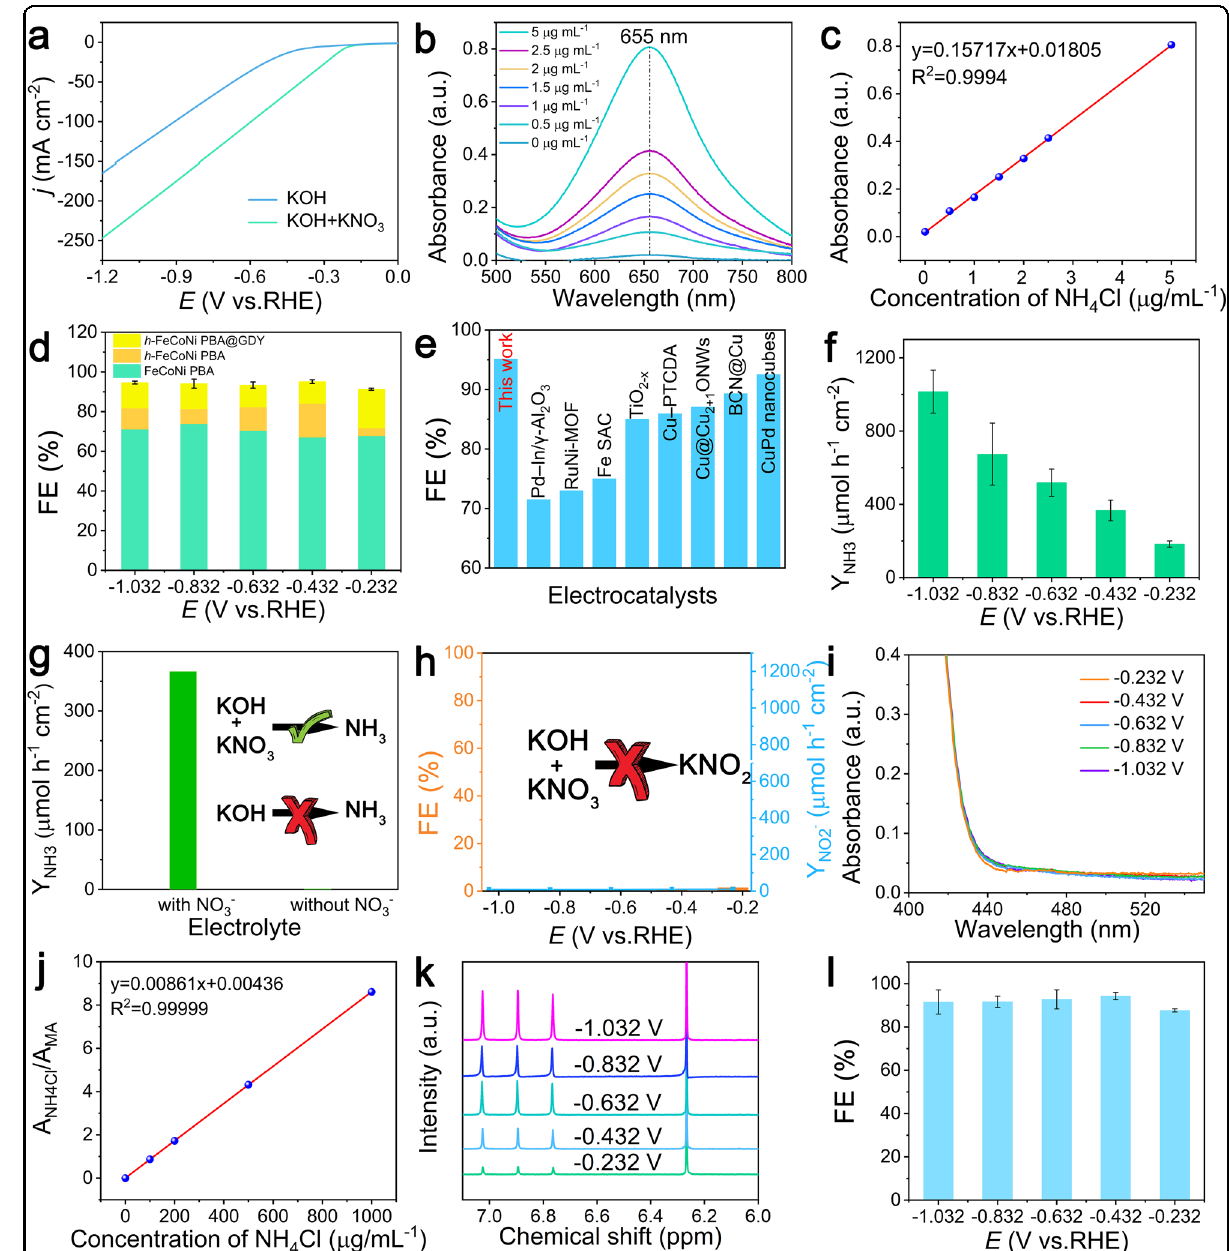
Fig. 5 Electrocatalytic performance. a LSV curves for h -FeCoNi PBA@GDY obtained in 1.0 M KOH solution, with and without 0.5 M KNO 3 , respectively. b UV – vis spectra determined with various NH 3 concentrations after incubation for 1 h under ambient conditions. c Corresponding calibration curves. d FEs of the samples obtained at different potentials. e Comparison of the ECNtRR performance of h -FeCoNi PBA@GDY with those of reported catalysts. f Y NH3 for h -FeCoNi PBA@GDY at different potentials. g Y NH3 for h -FeCoNi PBA@GDY in the electrolyte with or without NO 3 − . h FE and Y NO2- at different potentials. i Absorption spectra for N 2 H 4 determined at different potentials. j Calibration curves for determining NH 3 concentrations using the 1 H NMR method. k 1 H NMR spectra for 14 NH 4 + obtained at different potentials from h -FeCoNi PBA@GDY. l FEs for NH 3 production with h -FeCoNi PBA@GDY, determined at different